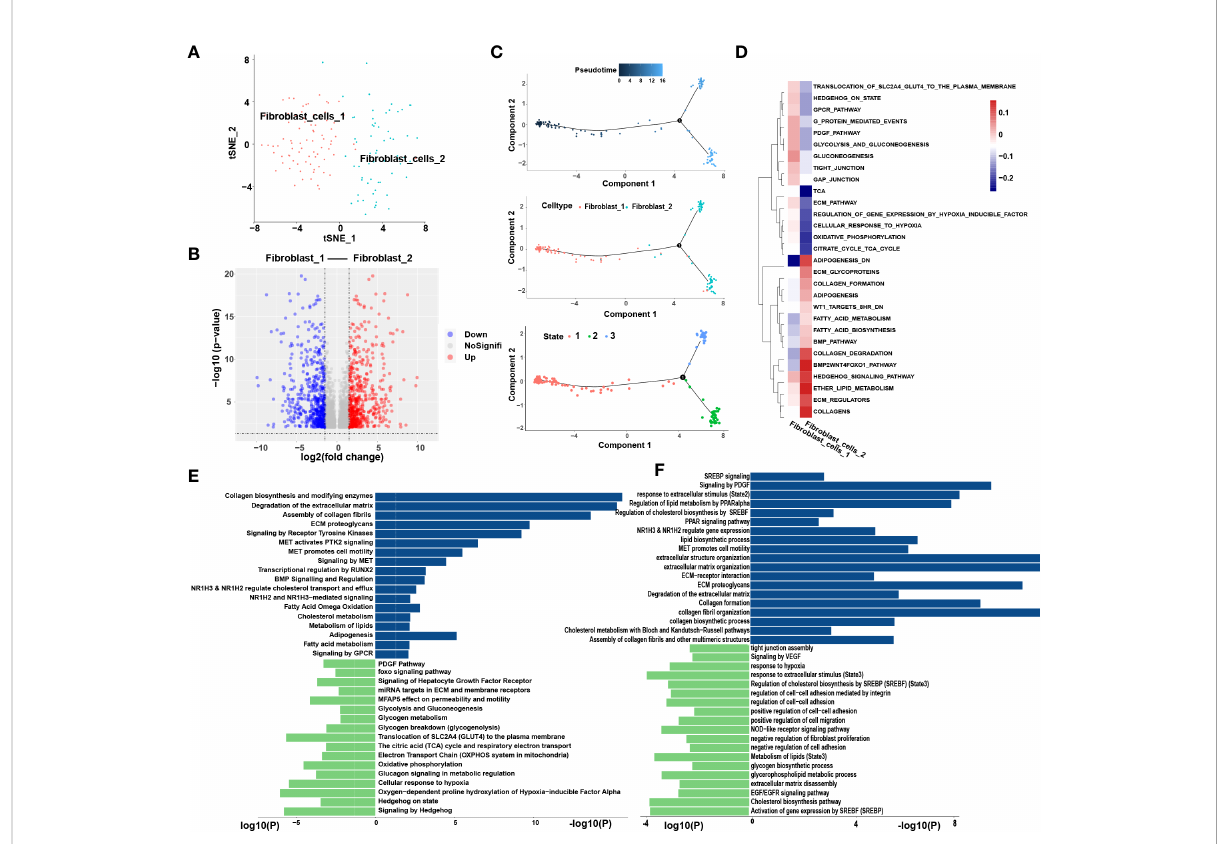
FIGURE 6 Similar metabolic and functional remodeling in fi broblasts. (A) tSNE plots showing 2 sub-cell types of fi broblasts. (B) The volcano plot illustrated the DEGs of each sub cluster, statistically signi fi cant DEGs were de fi ned with p< 0.05 and [logFC] > 1 as the cut-off criterion. (C) Differentiation trajectories of fi broblasts color-coded for pseudotime (upper) and sub-cell types (median) and states (lower). (D) The heatmap illustrates the activity of biological process and signaling pathway in each cell type by GSVA. (E) GO and KEGG pathway enrichment analyses of marker genes of fi broblast-2 (blue) and fi broblast-1 (green). (F) Enrichment analyses of marker genes of state2 (blue) and state3 (green) cluster. The height of each barplot shows the log10 of P-value calculated using the Metascape